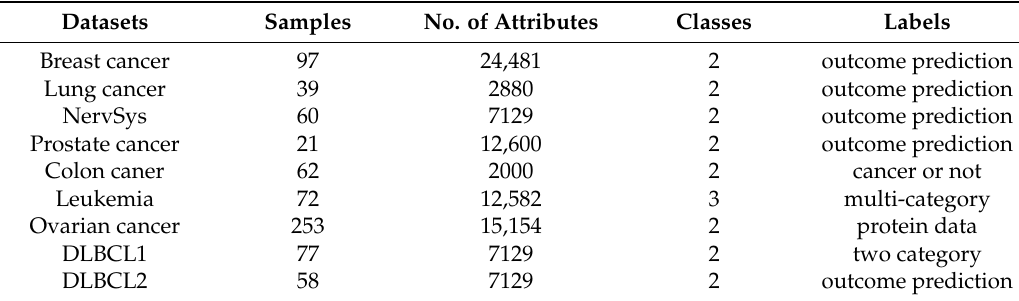
Table 3. Details of cancer